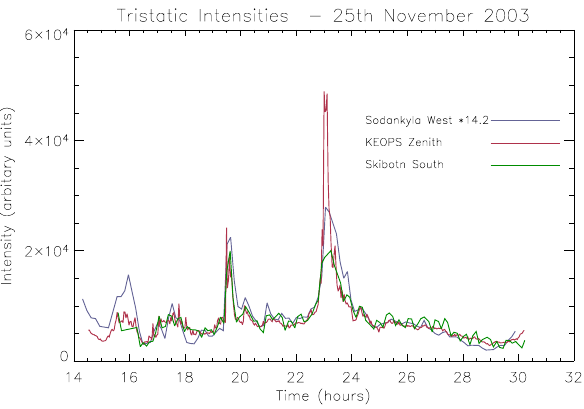
Fig. 3. 630.0nm intensities from KEOPS, Sodankyl¨a, and Skibotn on the 25 November 2003. As the intensities are not calibrated, the Sodankyl¨a data are scaled to match the other sites by a factor of the ratios of the median value of Skibotn to Sodankyl ¨ a data for this night. The directions shown point to the tristatic point above KEOPS.